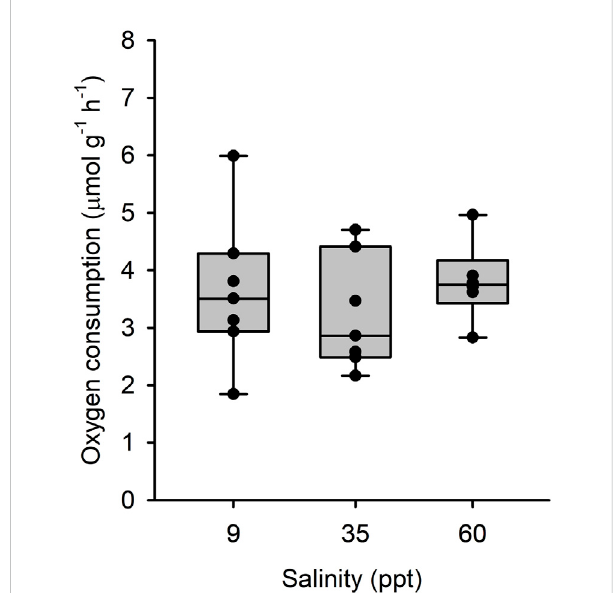
FIGURE 4 Oxygen consumption rate by isolated esophageal epithelia from toad fi sh acclimated to 9 (open bars), 35 (light grey) and 60 (dark grey) with different luminal salines representative of in vivo conditions. Median, range, upper and lower quartile as well as individual observations. N = 7, 7 and 6 for 9, 35 and 60 ppt, respectively. No statistical differences were